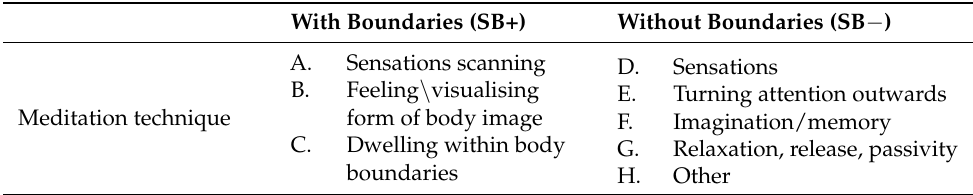
Table 2. Meditation techniques used for entering the SB